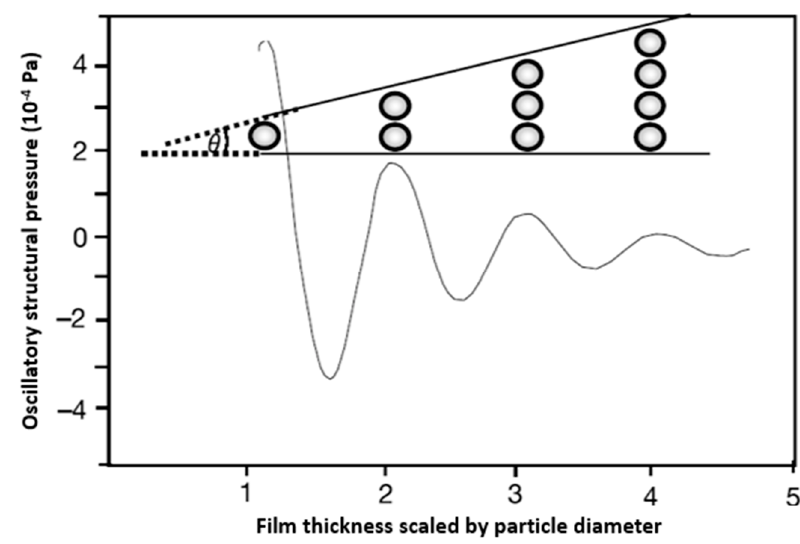
Figure 3. Oscillatory structural pressure as a function of the film thickness, scaled by particle diameter estimated from Equation (1). The particle diameter is 8 nm and the volume fraction is 0.4. Adapted with permission from [7]. Copyright 2003 Springer Nature.